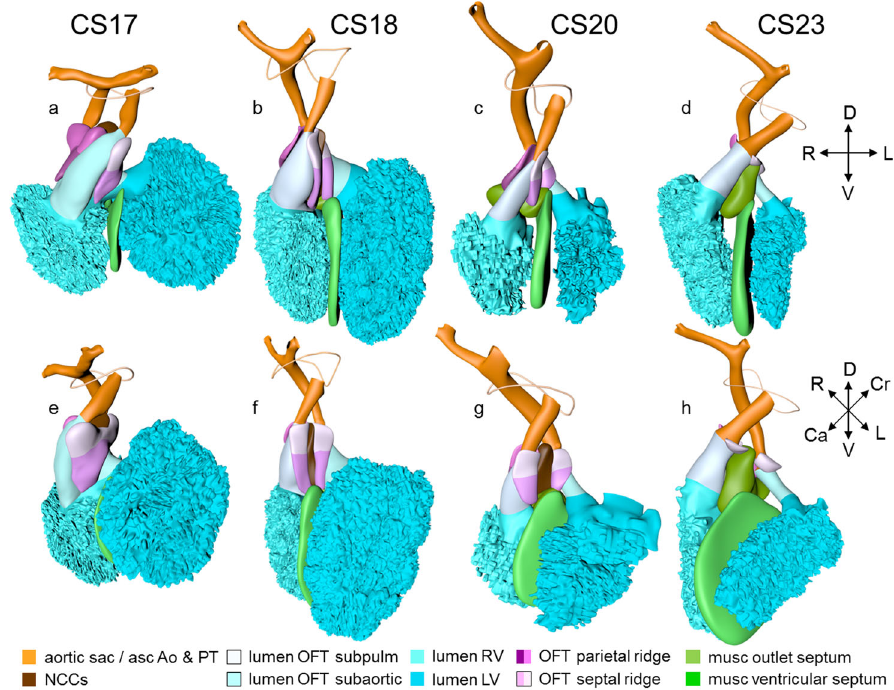
Fig. 10 Pictorial timeline of the formation of the subpulmonary infundibulum. Panels a – d show cranial views of the lumens of the left and right ventricles, the muscular ventricular septum, the lumen of the out fl ow tract with ridges and neural crest, and the arterial trunks, while panels e – h show left lateral views of the same structures. On completion of the fusion of the proximal out fl ow tract ridges at CS18, the neural crest cells largely disappear and myocardialization begins (Fig. 7h – n). Myocardialization proceeds from proximal to distal, opposite to the direction of septation, reaching the arterial valves at CS23. The myocardial septum, which then separates the subpulmonary and subaortic channels, also known as the embryonic outlet septum, is located on the right side of the muscular ventricular septum and is topographically part of the right ventricle. This right-sided position accounts for subsequent development into the free-standing muscular infundibulum. At CS23, the base of the subaortic channels is on the left side of the muscular ventricular septum, but the aortic root has not yet been incorporated in to the base of the left ventricle. All images are also available as preset views in the corresponding